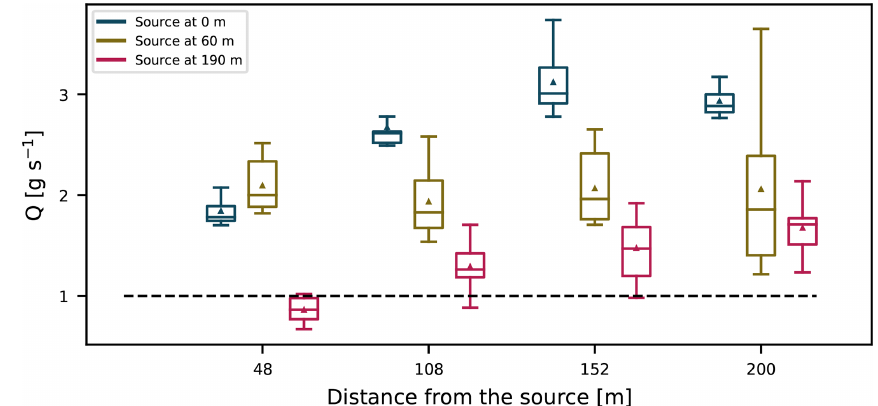
Figure 8. Estimates of the source strength using OTM 33A for the emission heights 190, 60, and 0m at four different distances. Boxes show the interquartile range, while the whiskers span from the 5th to 95th percentile of the data and show the mean and median. The dashed line refers to the true source strength used in the LES.